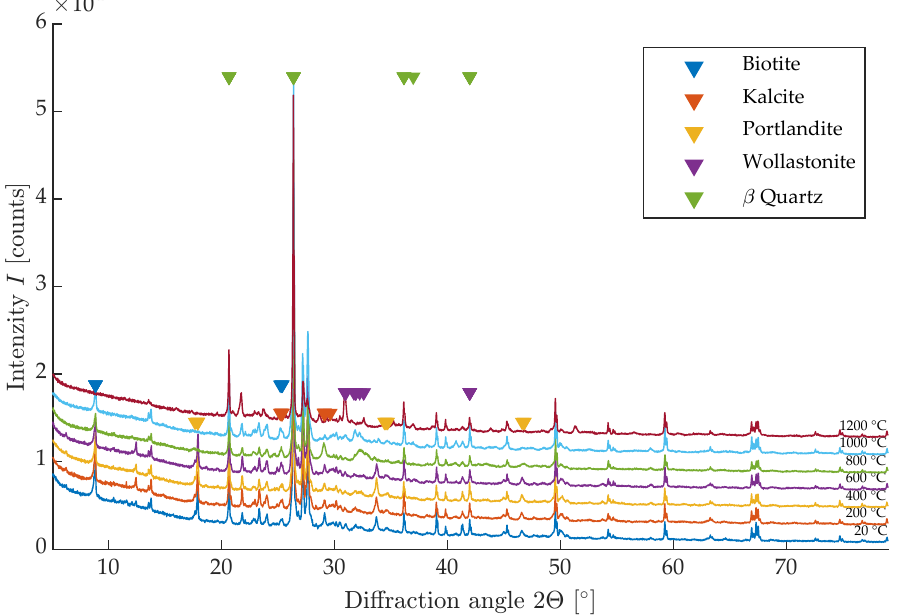
Figure 10. RTG diffraction analysis of tested mixture